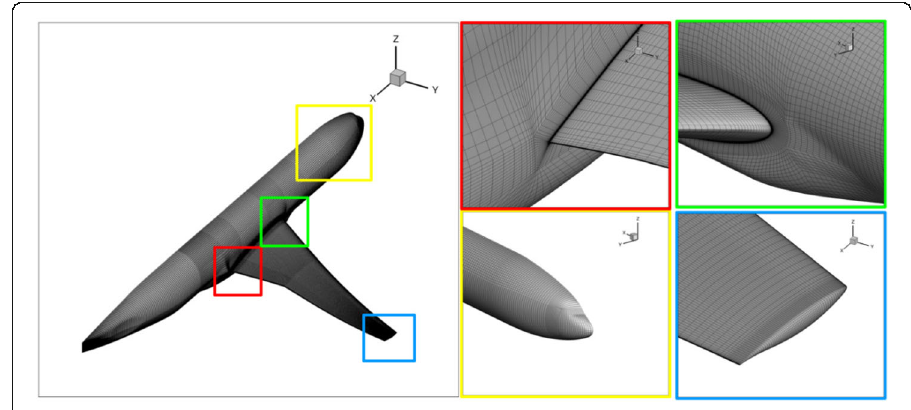
Fig. 2 Numerical grid and